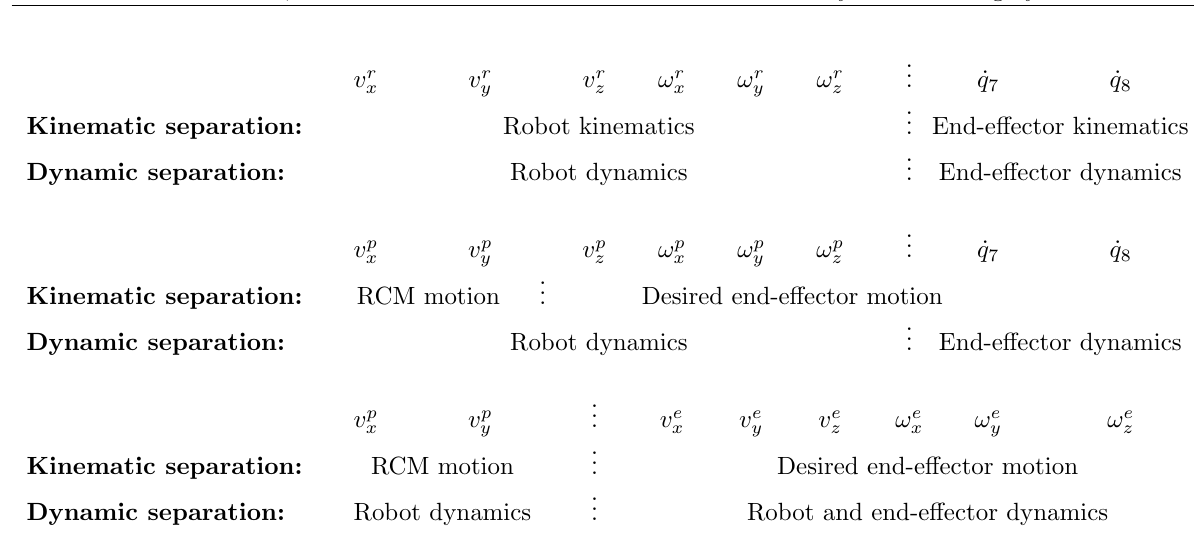
Figure 2: Separation of the workspace variables. The first representation with V B and end-effector kinematics and dynamics are separated, but the formulation is not suited for control because the end-effector variables are not present. The last formulation of the workspace variables is more suitable for control as it separates the entry point velocities and the end-effector velocity variables, and these can be treated